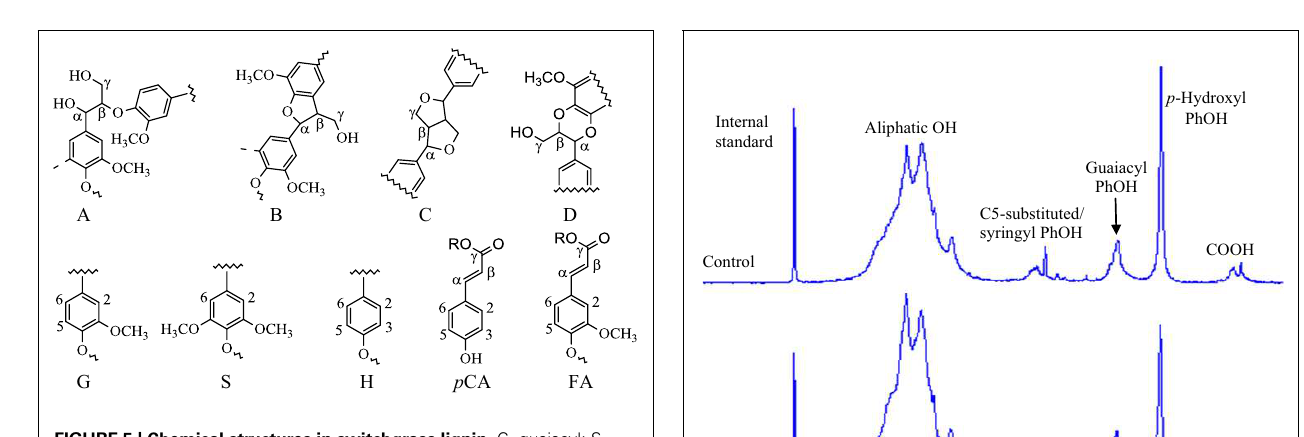
FIGURE 5 | Chemical structures in switchgrass lignin . G, guaiacyl; S, syringyl; H, p -hydroxyphenyl; A, β - O -4 ether; B, phenylcoumaran; C, resinol; D, benzodioxane; p CA, p -coumarate; FA, ferulate.